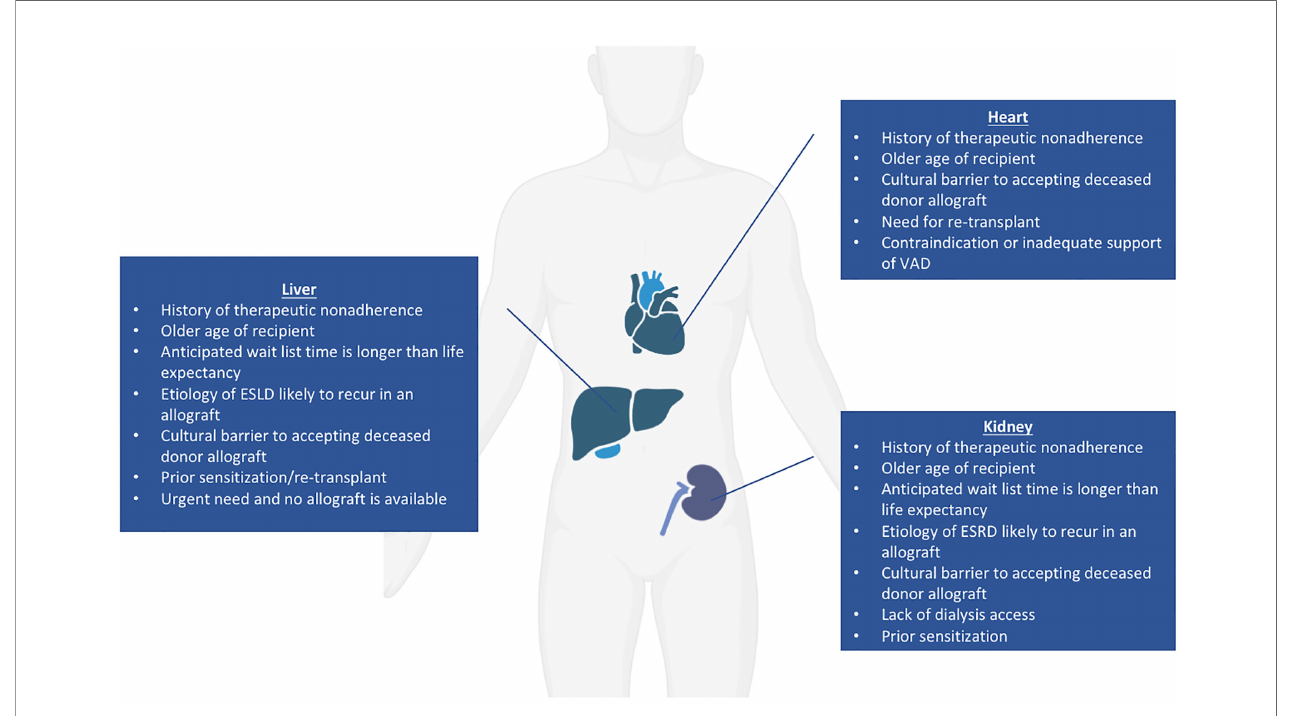
FIGURE 2 | Potential candidates for heart, kidney, and liver